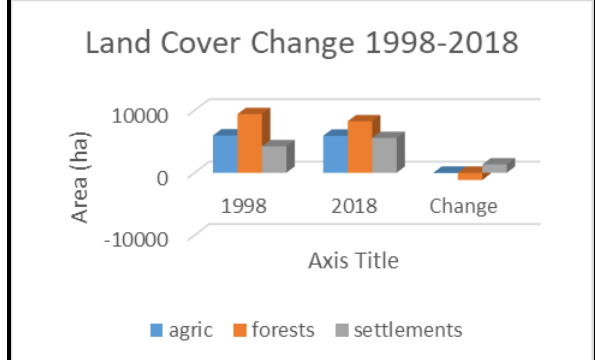
Figure 3. Change